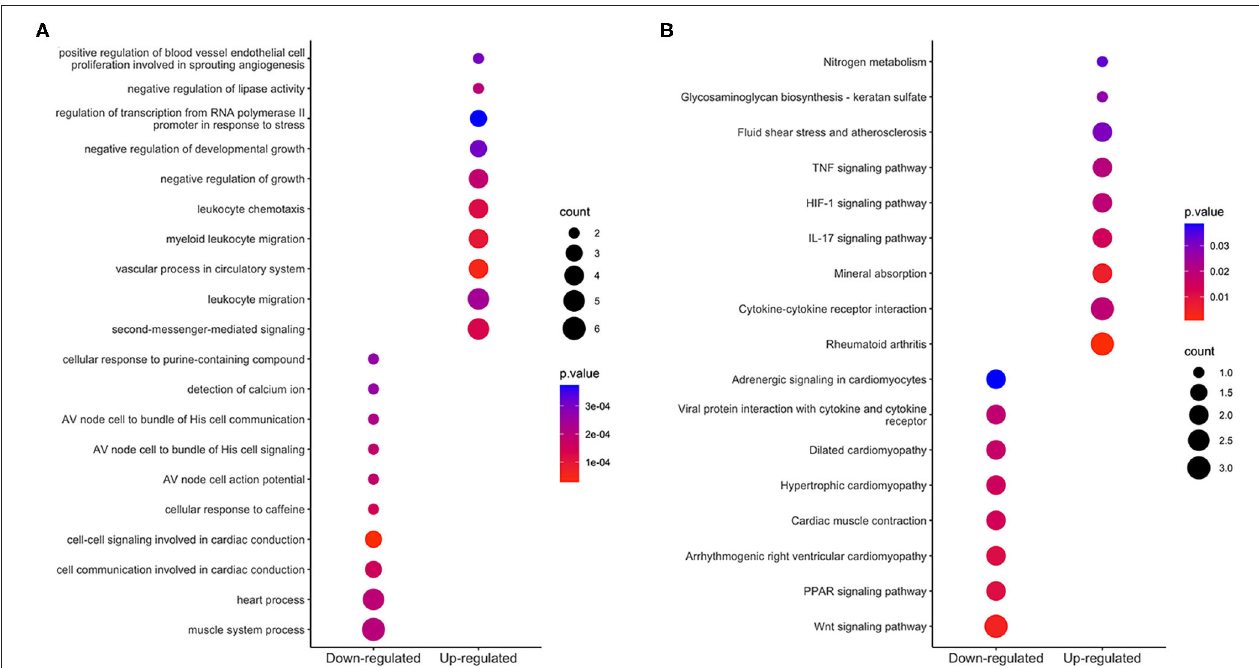
FIGURE 4 | Enrichment analysis of integrated DEGs. The color represents the p -value of the terms, while the x axis represents the different gene categories including up-regulated and down-regulated DEGs. Count refers to the number of DEGs enriched in a GO term or KEGG pathway. (A) The top 10 terms enriched among up-regulated and down-regulated integrated DEGs. (B) The results of KEGG analysis of the upregulated and downregulated integrated DEGs.